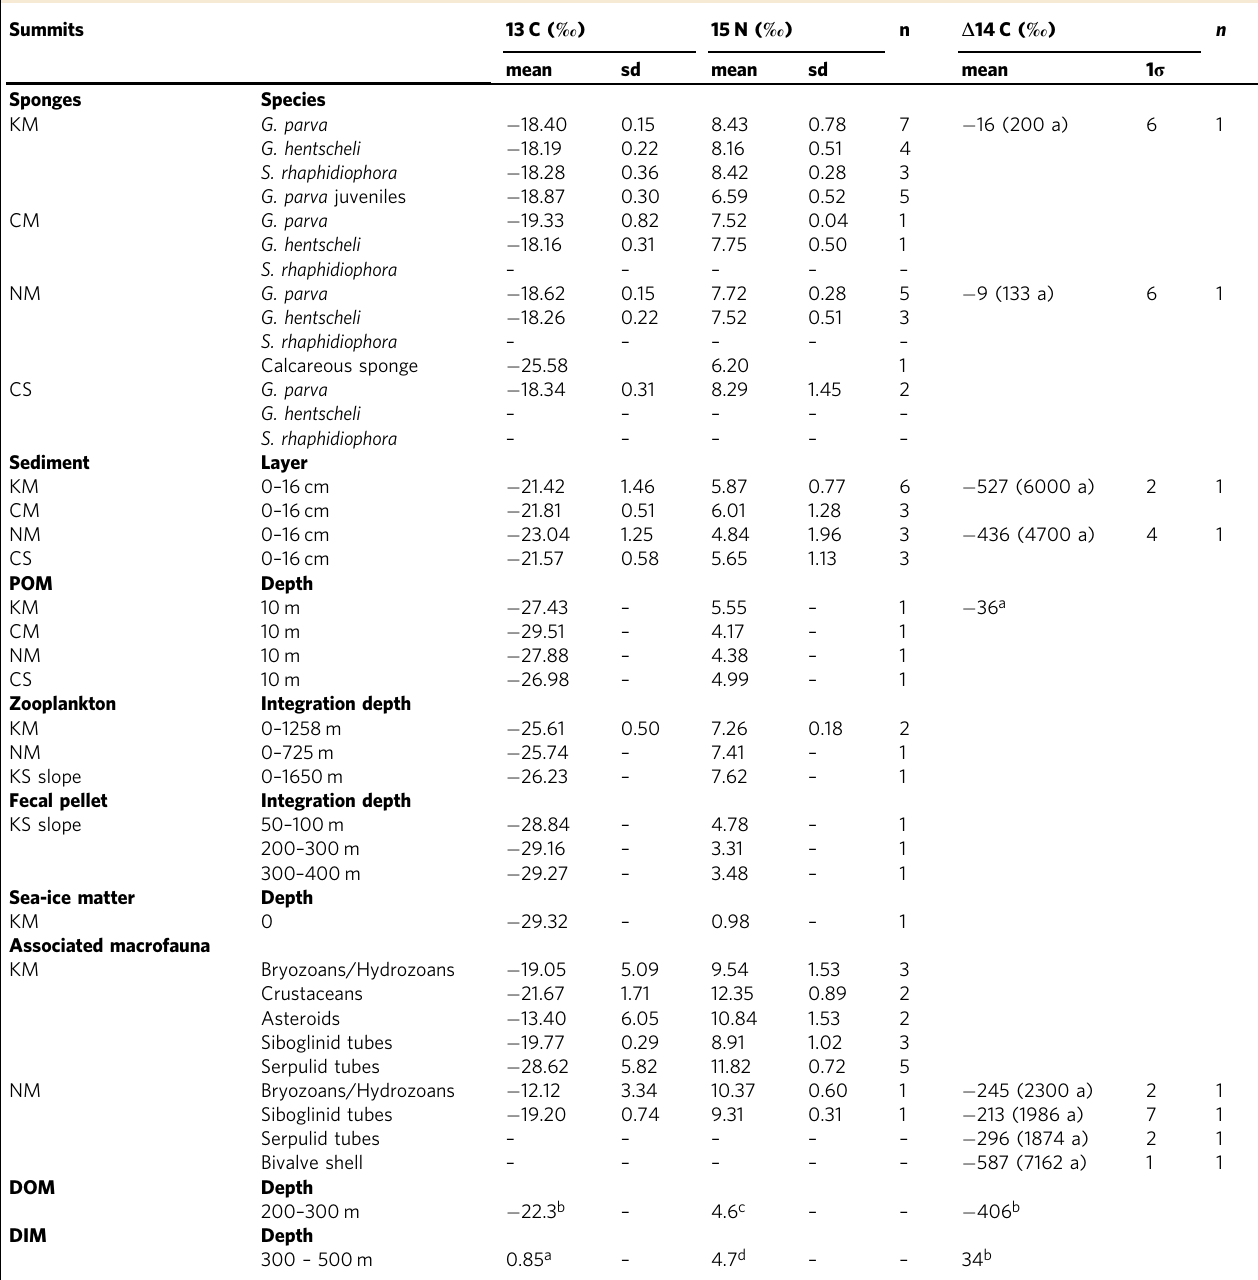
(Fig. 5 and Supplementary Table 3). The δ 13 C of sponge-speci fi c markers was more variable, varying between − 17.9 and − 25.7 ‰